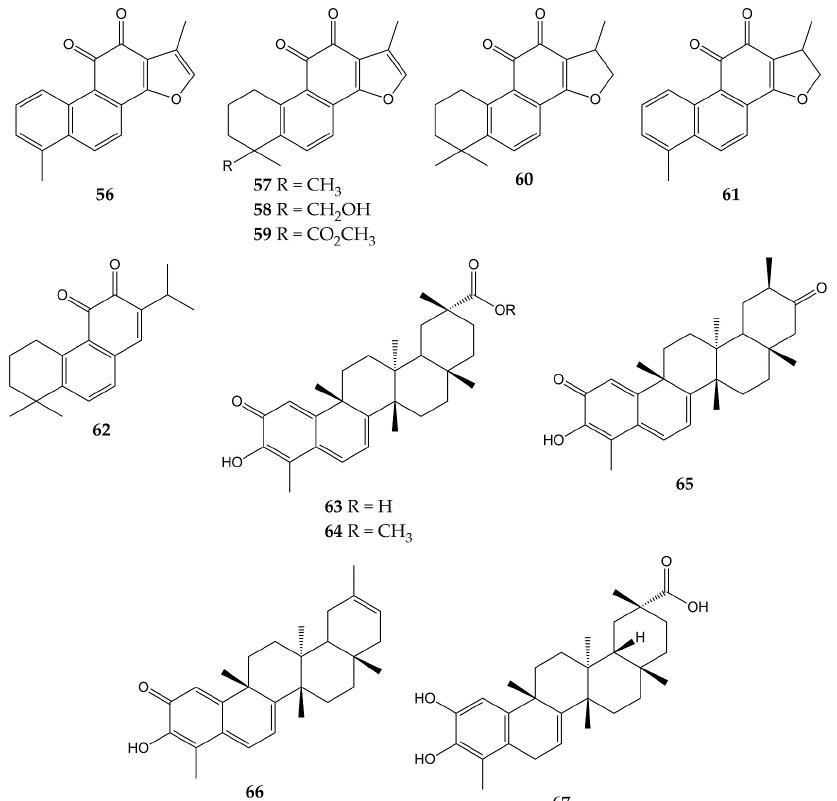
Figure 7. Chemical structures of quinones 56 – 67 .